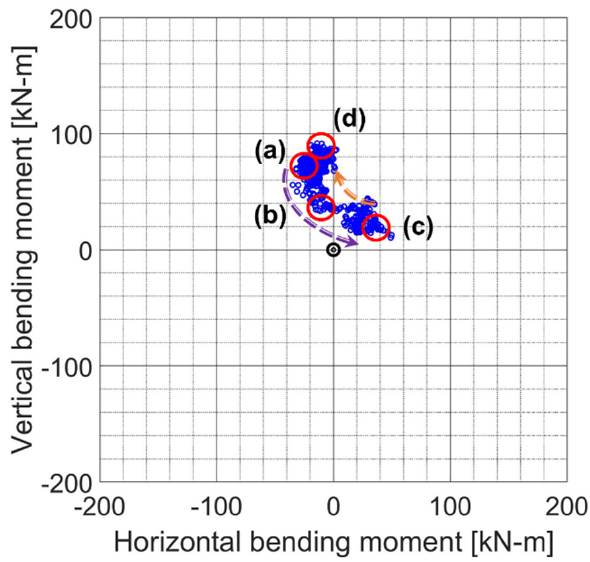
Figure 16. Plot of trajectories obtained during the port turn under the fully laden condition. Stage (a): Rudder angle 0-degree: NCR straight going (begin). Stage (b): Rudder angle changes from 0 to 12-degree (port). Stage (c): Rudder angle 12-degree: ship’s heading is gradually changing. Stage (d): Rudder angle 0-degree: NCR straight going (end).